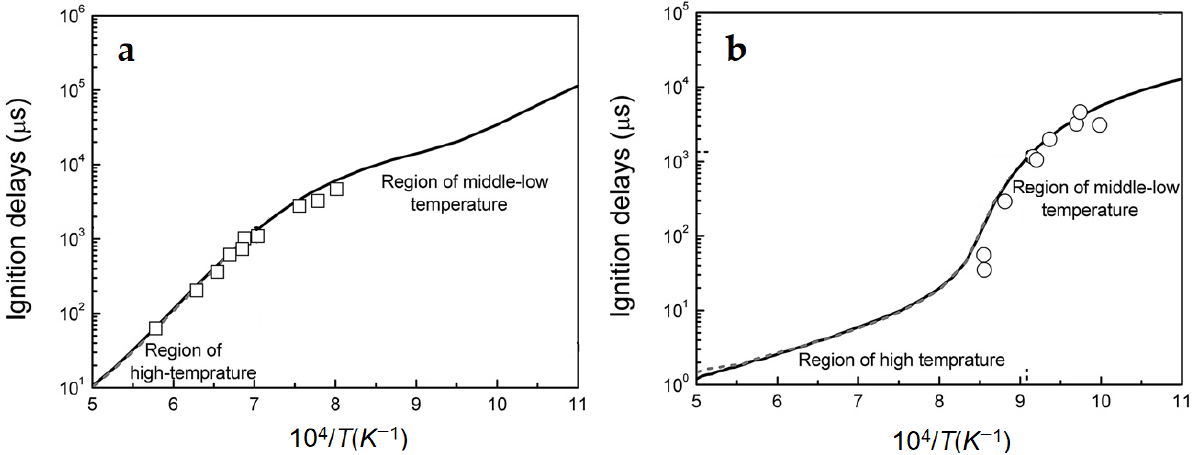
Figure 1. Temperature dependence of ignition delays for methane ( a ) and hydrogen ( b ). Symbols — experimental data, lines — kinetic calculation results (adapted from [25]).